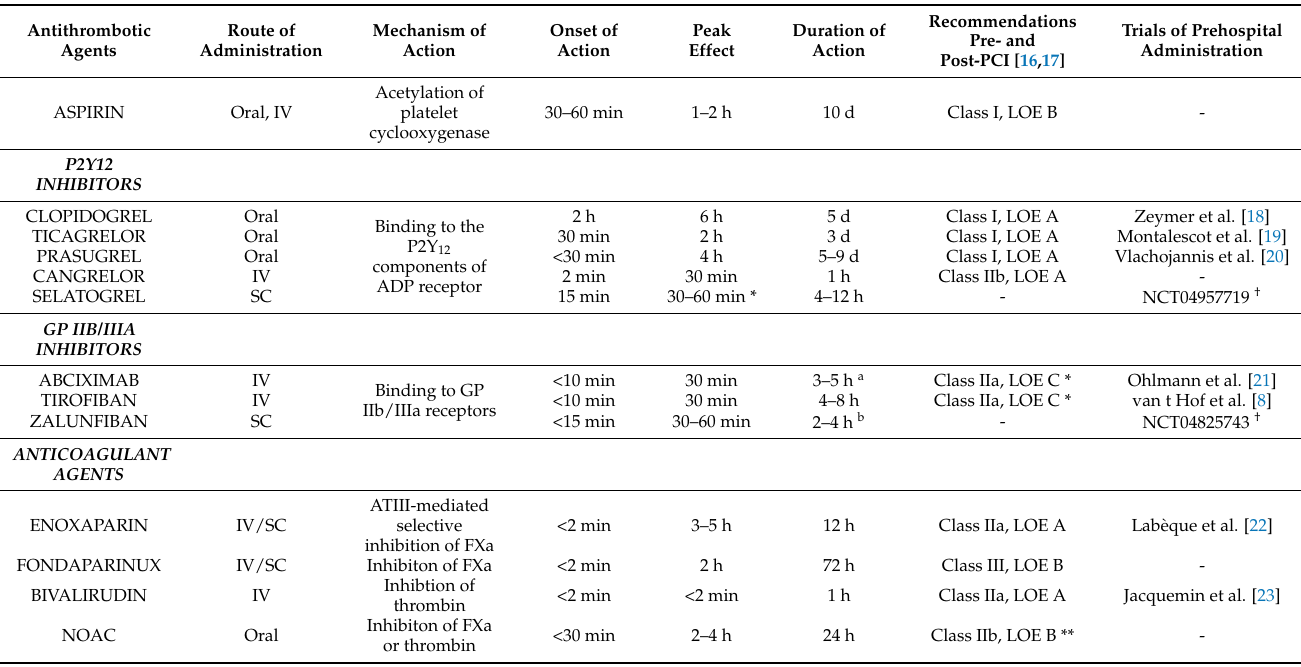
Table 1. Major characteristics of traditional and newer antithrombotic